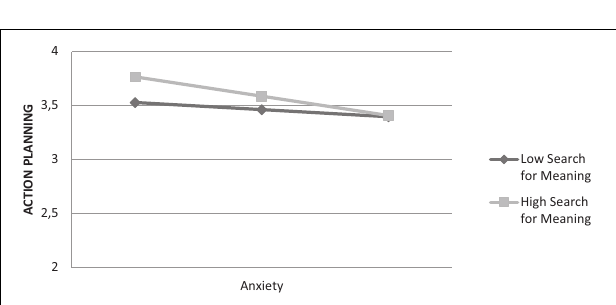
FIGURE 4 | Effect of anxiety on action planning coping style is moderated by search for meaning in life.